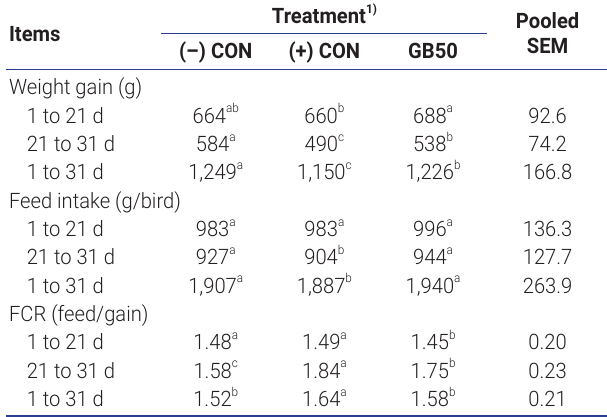
Table 2. Growth performance, feed intake and feed conversion ratio of broiler chickens (Trial 1) Items